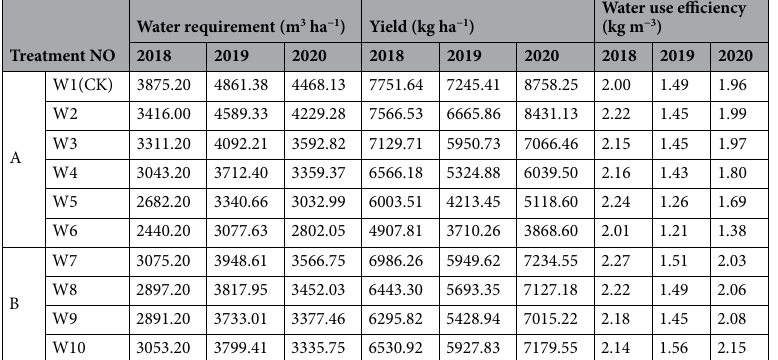
Table 3. Effects of soil water deficit on rice yield, water requirement and water use efficiency. The actual soil moisture content of the field was determined as a percentage of field capacity(θ), reflecting the degree of soil water deficit. In group A, WI:100% of field capacity; W2:90–100% of field capacity; W3:80–90% of field capacity; W4:70–80% of field capacity; W5:60–70% of field capacity; and W6:50–60% of field capacity. In group B, soil moisture deficit conditions were applied at different growth stages. W7: a filling stage deficit (70–80% of field capacity); W8: a flowering stage deficit (70–80%); W9: a booting stage deficit (70–80%); and W10: a tillering stage deficit (70–80%). The relative soil water content during the other growth stages was maintained at 80–90% of field